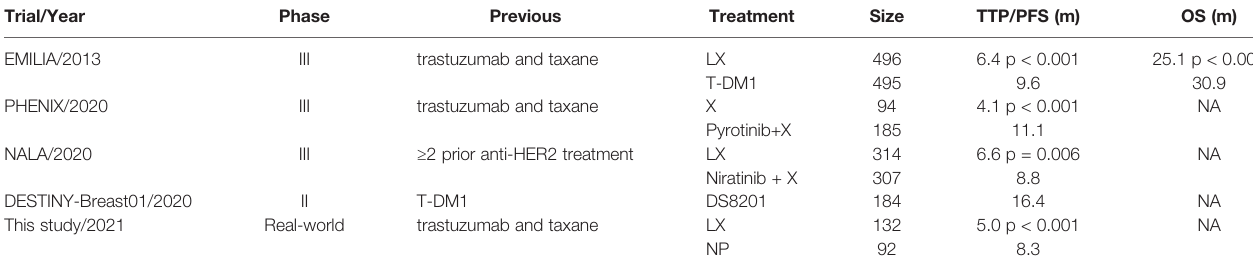
TABLE 3 | Trials of novel regimens in second line treatment for HER2-positive MBC. Trial/Year Phase Previous